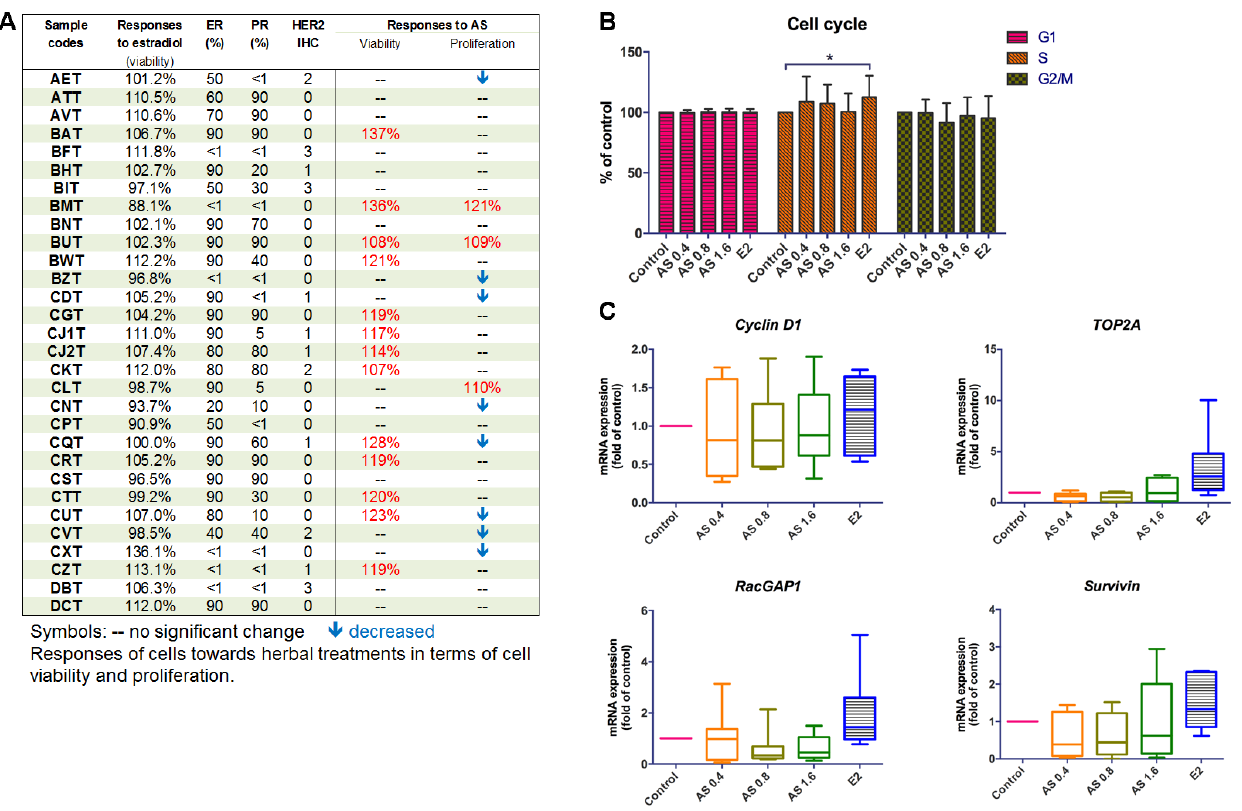
FIGURE 2 | Effects of AS aqueous extract on human primary breast cancer cells. (A) Summary of ER, PR, HER2 expressions, and the responses of cells towards AS extract treatments (0.4, 0.8, or 1.6 mg/ml) or 17 β -estradiol (E2, 0.1 µM) in epithelial cell-enriched primary breast cell samples. (B) Cell cycle phase distribution of 25 samples of human primary breast cancer cells. Data were expressed as mean percentage of control. (C) mRNA expressions of proliferation-related genes (n = 8). Data were normalized to corresponding GAPDH expressions in control cells and were expressed as mean fold of control. Mean + SD; statistical differences were determined by one-way ANOVA, followed by Dunnett test, with *p < 0.05, **p < 0.01, ***p < 0.001 against untreated